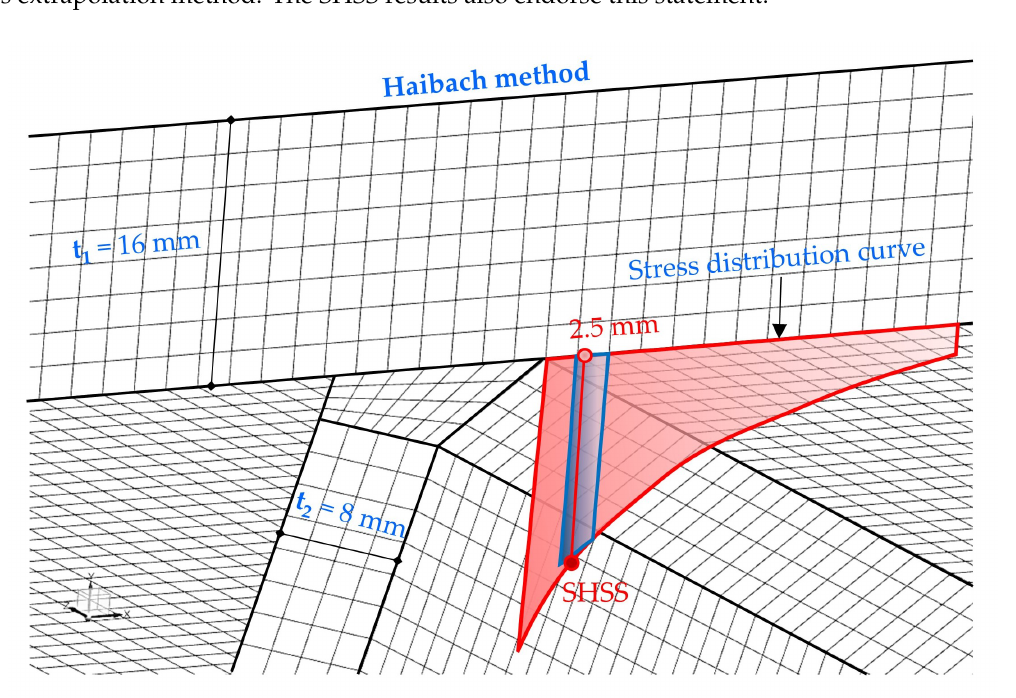
Figure 2. Haibach method for evaluation of SHSS at the weld-toe with 2.0 mm CHEXA20